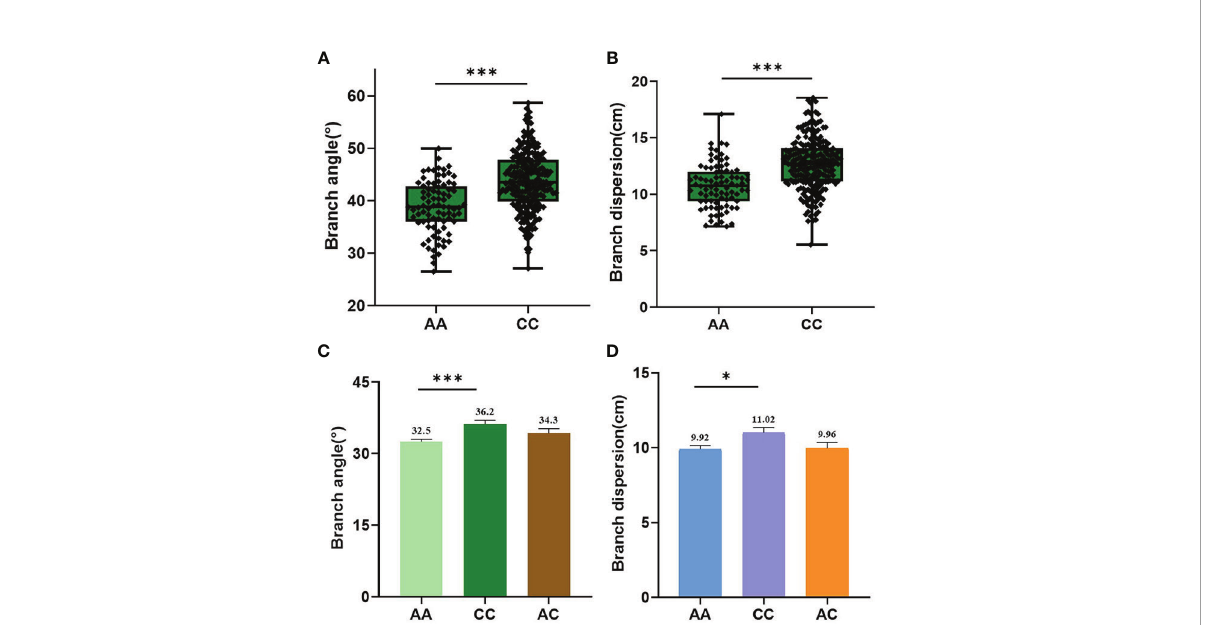
FIGURE 5 Phenotypic variation of the signi fi cant SNP chrA03_6002385 for qBAD.A03-2 . (A) Haplotype analysis of chrA03_6002385 for BA in association population. (B) Haplotype analysis of chrA03_6002385 for BD in association population. (C) Haplotype analysis of chrA03_6002385 for BA in segregated progeny derived from remaining heterozygous accession 8S128. (D) Haplotype analysis of chrA03_6002385 for BD in segregated progeny derived from 8S128. * and *** represent the signi fi cant level at P=0.05 and 0.001 respectively, as determined by Student ’ s